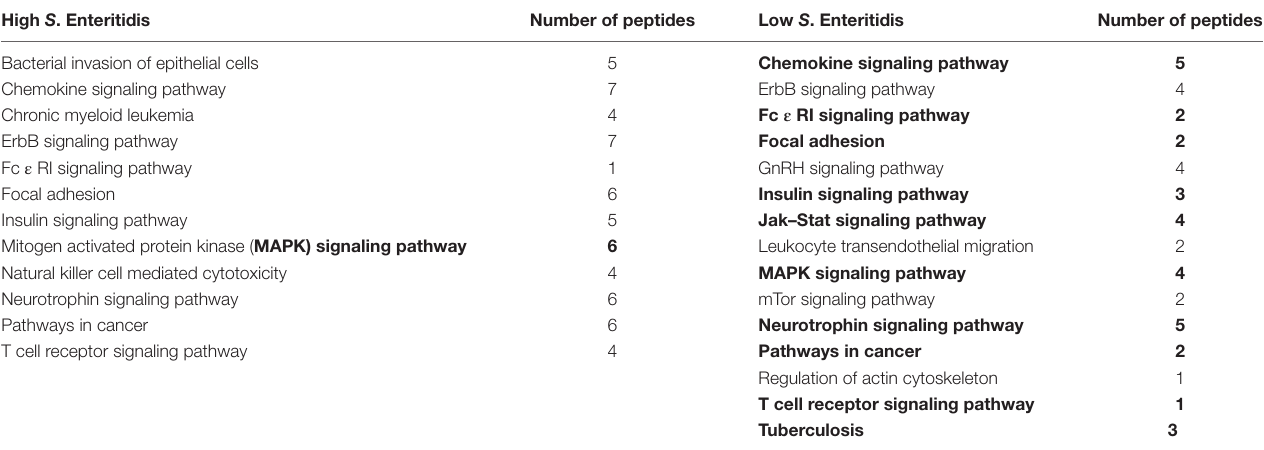
TaBle 3 | Kyoto Encyclopedia of Genes and Genomes (KEGG) pathways identified with the peptide array at the middle stage infections in chickens with high and low levels of Salmonella Enteritidis colonization. high S . enteritidis